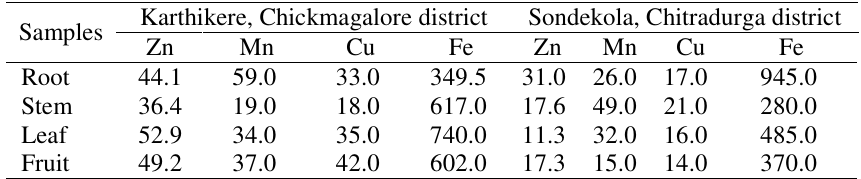
Table 2. Comparative account of micro elements (in ppm) of the root, steam, leaf and fruits samples of Withania somnifera (Linn.) Dunal at Karthikere and Sondekola of Karnataka,